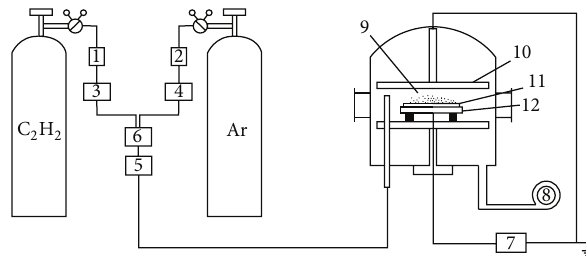
Figure 1: PECVD schematic diagram 1,2-regulators cans; 3,4,5-flow meter; 6-mixing chamber; 7-RF power; 8-vacuum pump; 9-C 2 H 2 and Ar-mixed plasma gas; 10-upper plate; 11-sample; 12-lower plate.